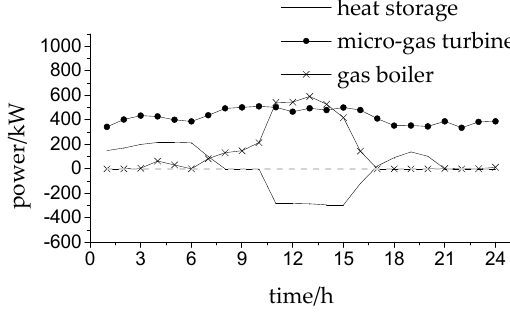
Figure 10. The optimization results of the heating system.